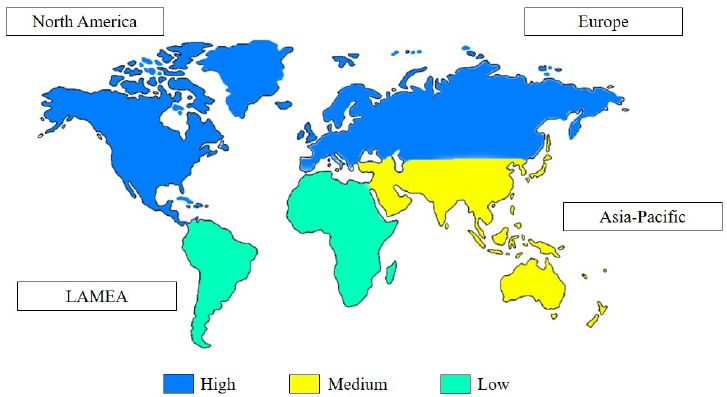
Figure 3. Forecast of natural preservatives market potential in North America, Europe, Asia-Pacific, and LAMEA regions from 2018–2026. Data gathered from Mordor Intelligence [37] .